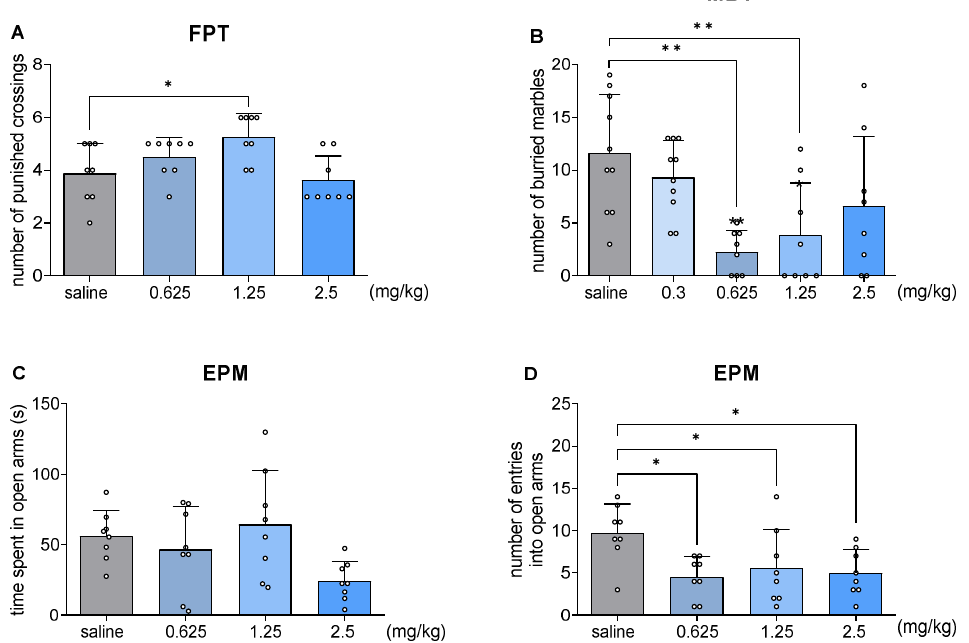
Figure 2. The influence of JJGW07 on the number of punished crossings (Panel ( A )), the number of buried marbles (Panel ( B )), and time spent in the open arms (Panel ( C )), as well as the number of entries into open arms (Panel ( D )). ( A ) Mice were placed in the four-plate apparatus, and after a 15 s adaptation period, each crossing from one plate to another was punished by an electric shock. The number of punished crossings was measured for 60 s. ( B ) Mice were placed individually in cages with a 5 cm bedding layer, where 20 glass balls were placed. The number of buried marbles after 30 min of the test was counted. ( C , D ) In the elevated plus maze test, mice were placed individually in the center area of the maze and observed for 5 min. The number of entries into the open arms, as well as the time spent in the open arms, was measured. JJGW07 was administered intraperitoneally ( ip ) 30 min before the test. The control group received an injection of 0.9% NaCl ( ip ). Values are expressed as means ± SD; n = 8 mice per group. Statistical analysis: one-way ANOVA (Newman–Keuls post hoc), * p < 0.05, ** p < 0.01 vs. control group, FPT—the four-plate test, MBT—the marble-burying test, and EPM—the elevated plus maze